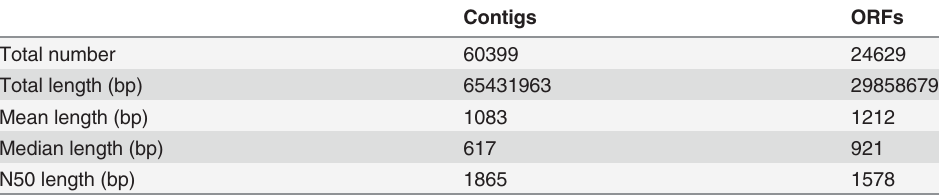
Table 4. Summary of assembly